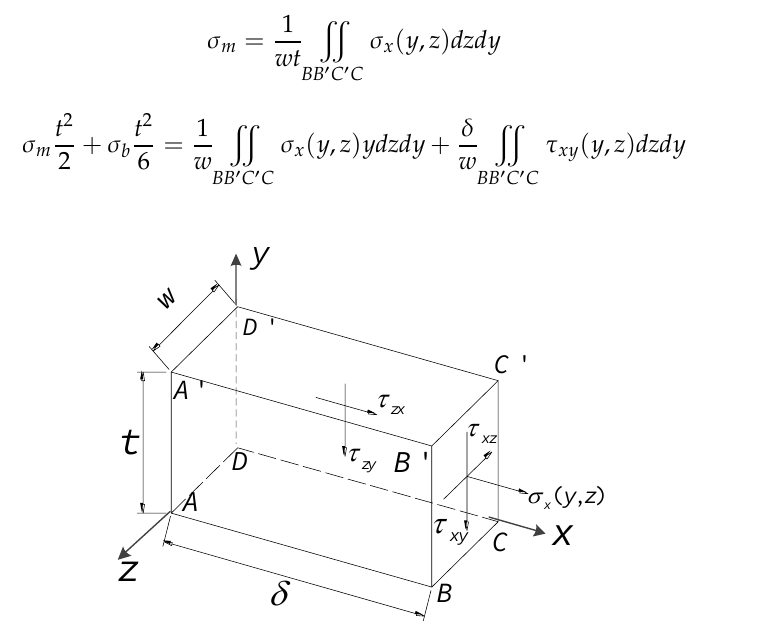
Figure 3. Stress distribution of the 3D solid element isolated body.